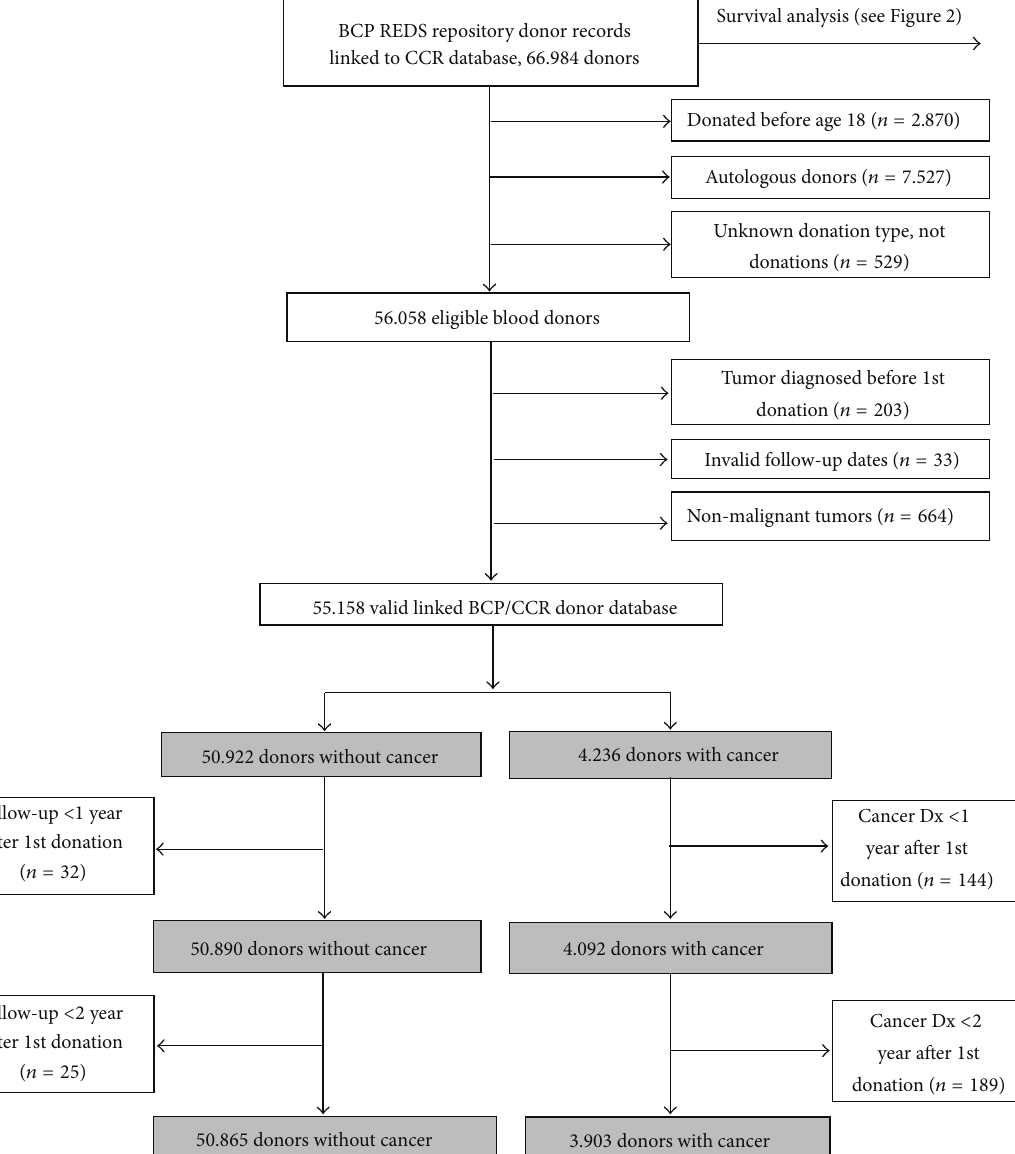
Figure 1: Flow diagram of master linked database, CCR: California Cancer Registry, BCP: Blood Centers of the Pacific, San Francisco, CA, 1991–2009. Note: eligible study populations analyzed to estimate standardized incidence ratios are shown in